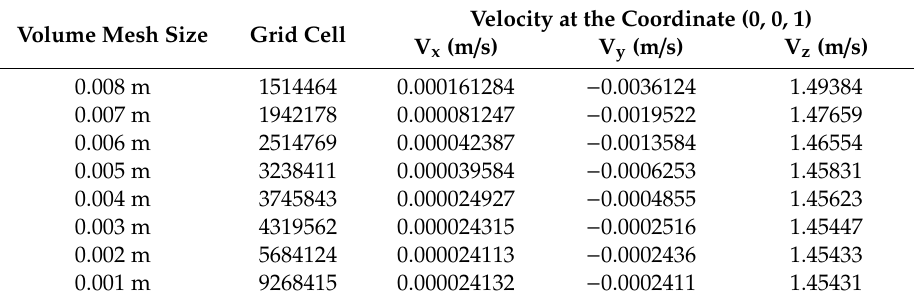
Figure 3. Schematic diagram of mesh division: ( a ) capsule surface mesh; ( b ) annular surface mesh; ( c ) O-shaped structured mesh; ( d ) interface merging mesh. Table 2. The encryption inspection of volume mesh.